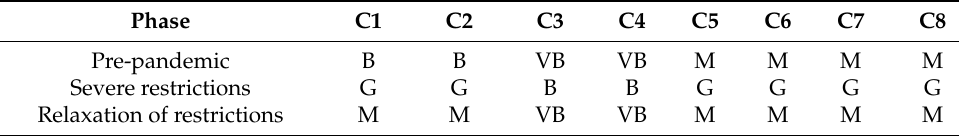
Table 7. BikeWay quality for the cycle paths in the UFRN central